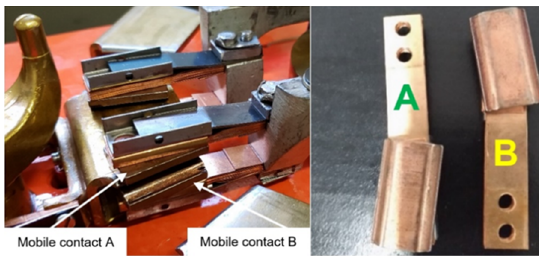
Figure 4. Mobile contacts studied.